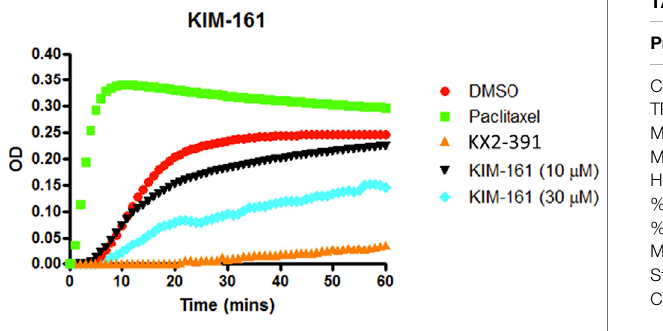
FIGURE 9 | Tubulin polymerization assay for KIM-161 at 10 and 30 µM comparedtopaclitaxel(10 µM)andKX2-391(10 µM)aspositivecontrols.The negative control (vehicle) contained DMSO (1% v/v). The effect on the tubulin assembly was monitored turbidometrically at 340 nm every 30 s for 60 min at 37 ° C. Fold inhibition of tubulin polymerization was calculated using the V max value for each reaction. The results represent the mean for three separate